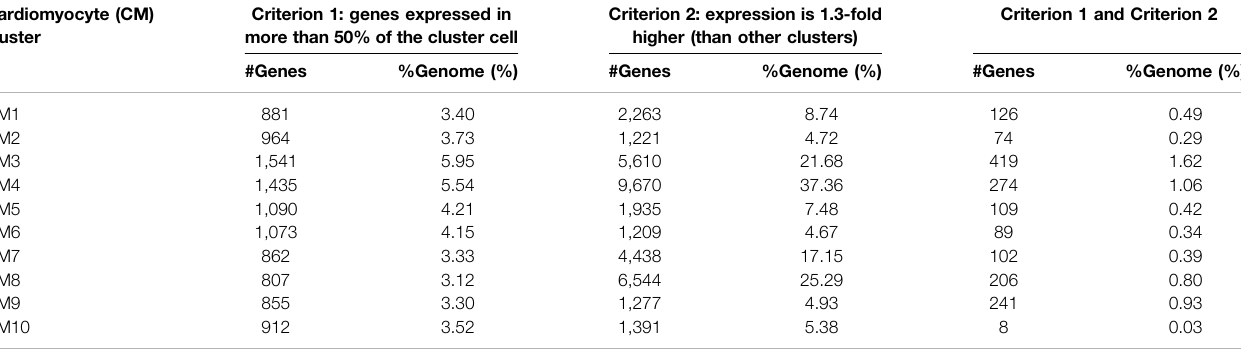
TABLE 1 | Number and proportion of genes passing the cluster marker criteria: expressing in more than 50% of the cluster cell and having at least 1.3-fold abundance. Cardiomyocyte (CM) Criterion 1: genes expressed in Criterion 2: expression is 1.3-fold cluster more than 50% of the cluster cell higher (than other clusters)